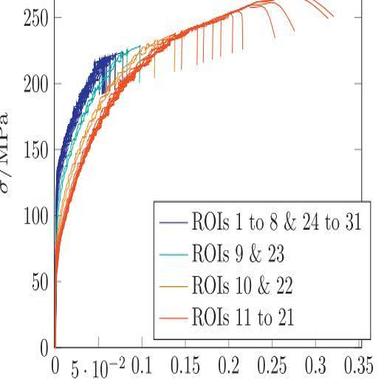
Measured logarithmic stress vs. strain curves from all the ROIs considered. For better understanding the figure, the reader is referred to the web version of the paper.